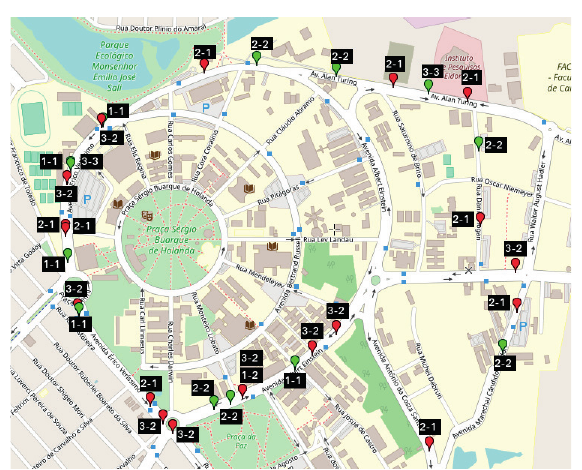
Figure 7. Map created with Naive